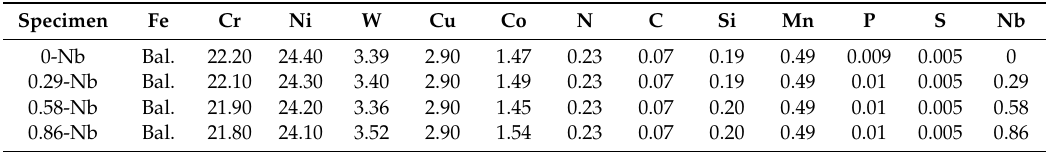
Table 1. Chemical composition of 22Cr25NiWCoCu stainless steels with 0–0.86 wt.%